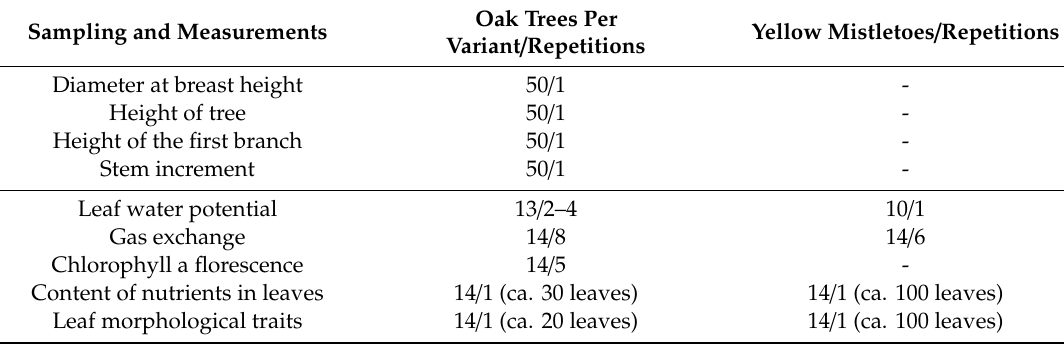
Table 1. The description of sample sizes for conducted